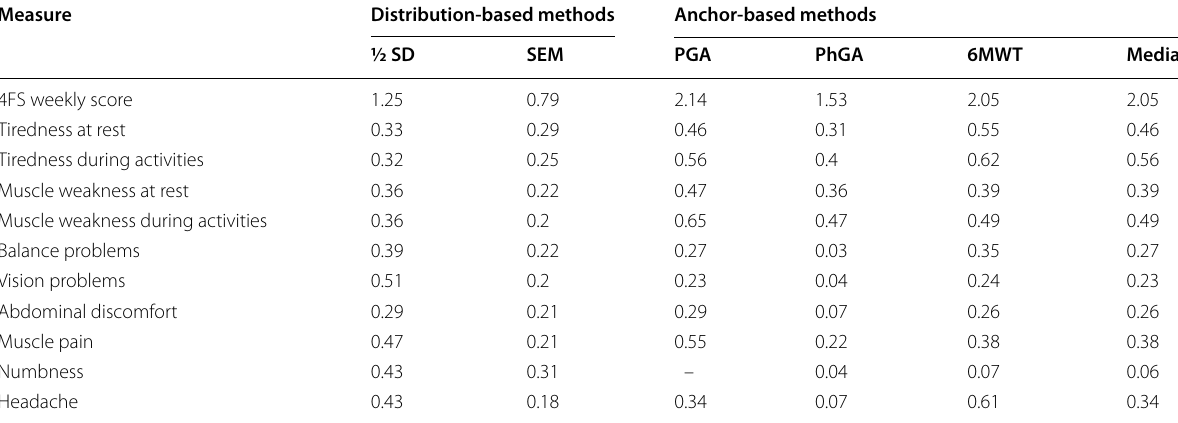
–indicates a logically inconsistent value was found, in which improved patients had worse PMMSA item scores, and this value was excluded as a candidate threshold value 4FS Fatigue 4 Scale; 6MWT = error of measurement